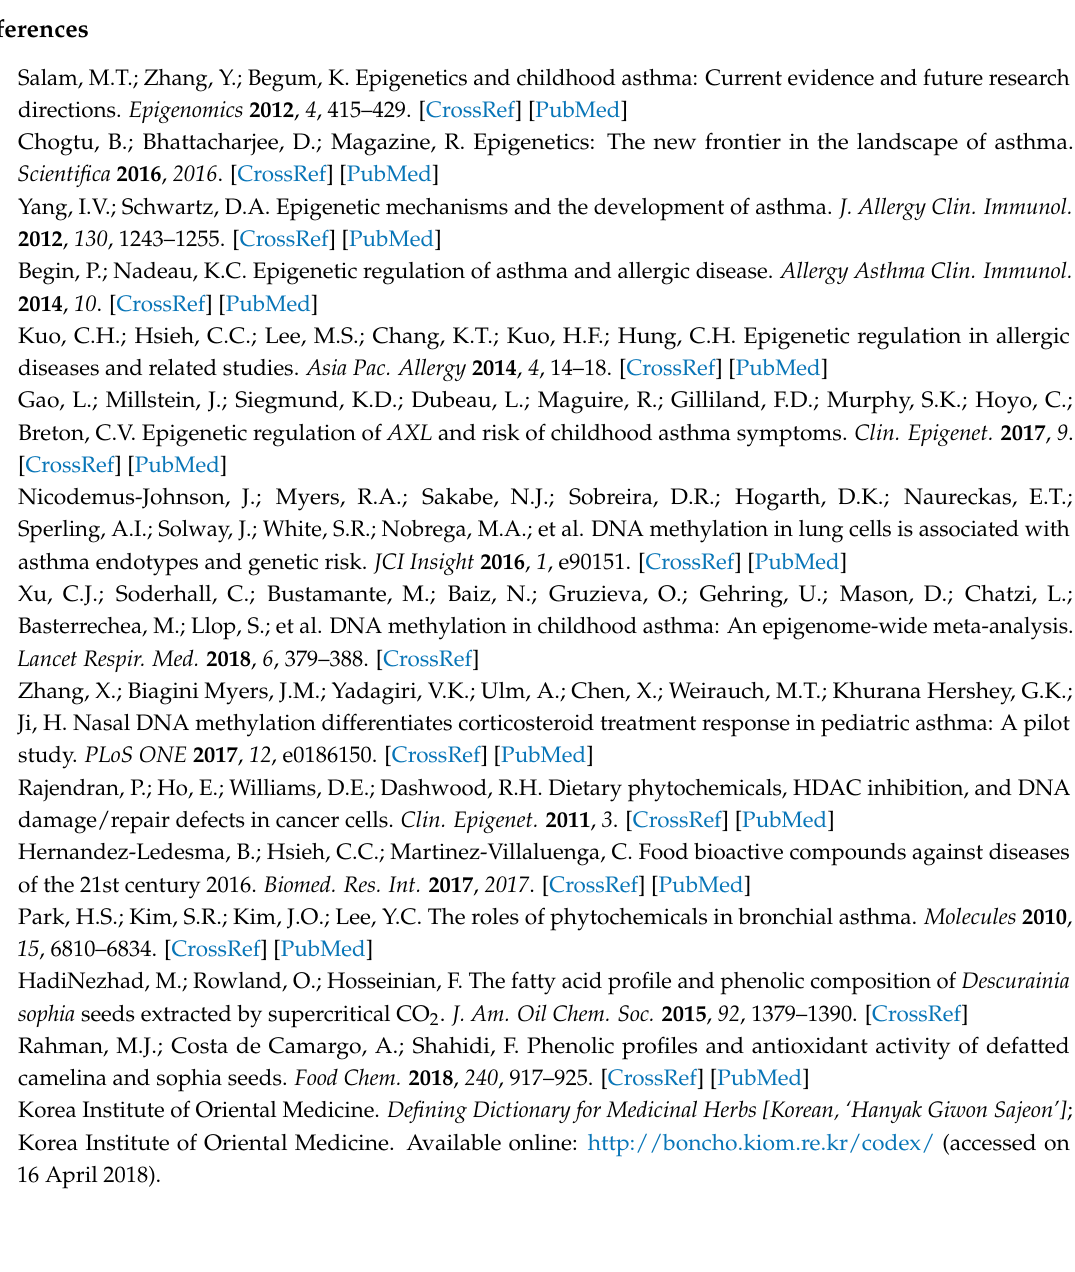
Figure S2: Experimental scheme and sample information, Figure S3: Histogram for percent methylation distribution, Figure S4: Histogram for the read coverage, Figure S5: Correlation plot between methylation and expression of candidate genes, Table S1: DMR list in OVA vs. Saline, Table S2: DMR list in DSE vs. OVA, Table S3: DMR list in anti-asthmatic patterns, Table S4: DAVID result in hyper/hypo pattern, Table S5: DAVID result in hypo/hyper pattern, Table S6: DAVID result in 18 candidate genes, Table S7: Network genes and chemicals associated with